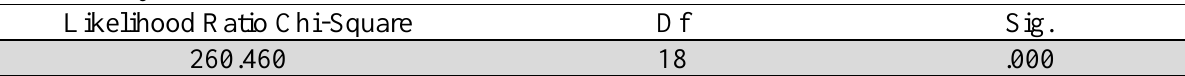
The summary of Omnibus